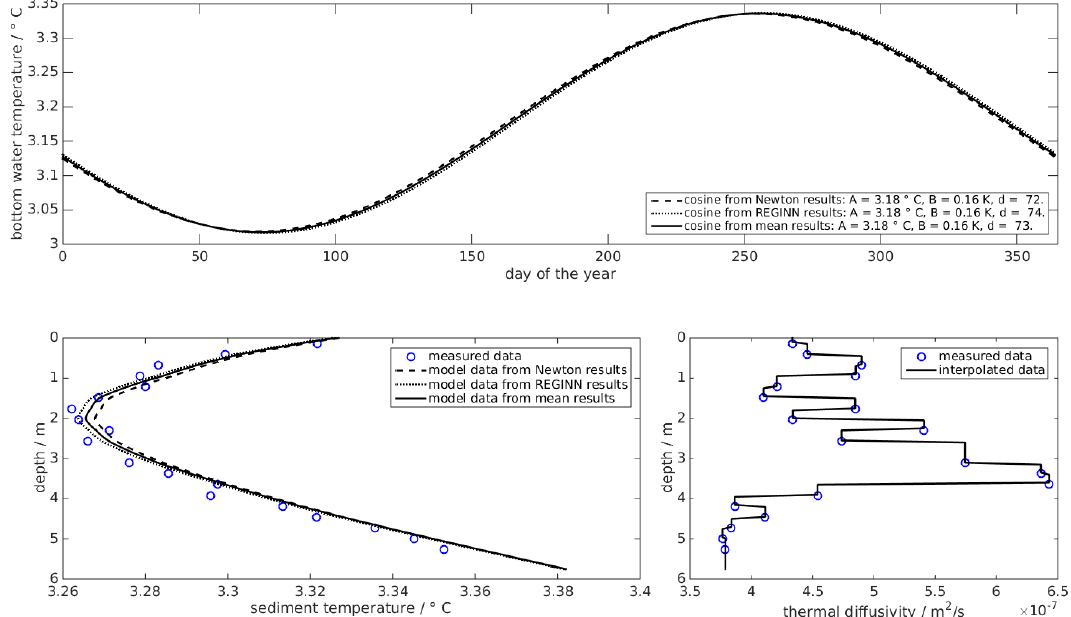
Figure 5. Inversion of the data set west of Nuuk. In the upper panel, the cosine functions as results of the inversion schemes are plotted: the mean result of the Newton algorithm in dashed line, the REGINN result in dashed line with dots and the overall mean in a straight line. In the lower panels the measured temperature (left) and thermal diffusivity (right) are depicted. The resulting temperature–depth profiles from the modeling with the inversion results (the line styles are the same as above) are plotted together with the measured temperatures in the bottom left